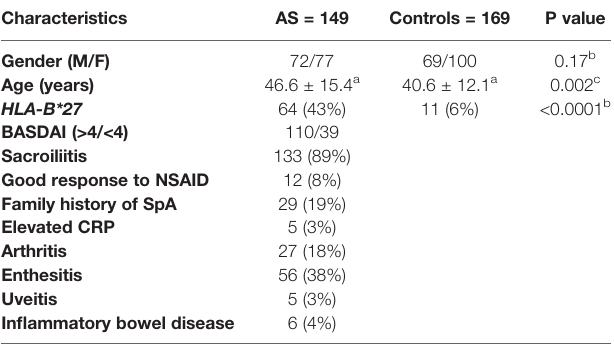
TABLE 3 | Characteristics of AS patients and healthy controls.